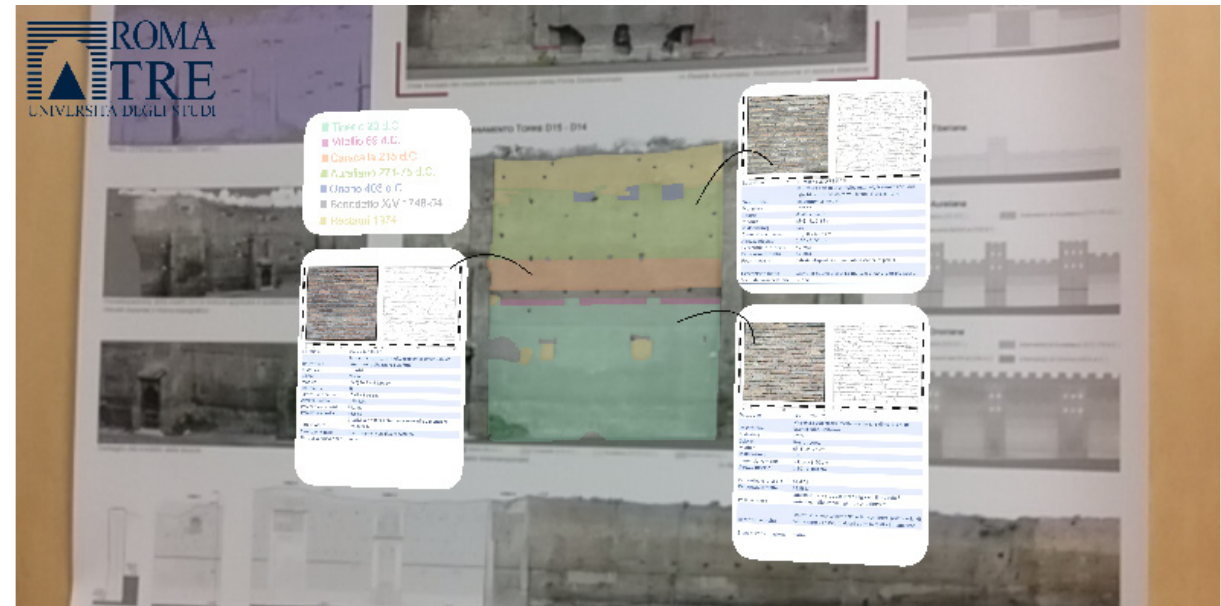
Figure 6. Augmented Reality can be used to store and visualize data like the different types of